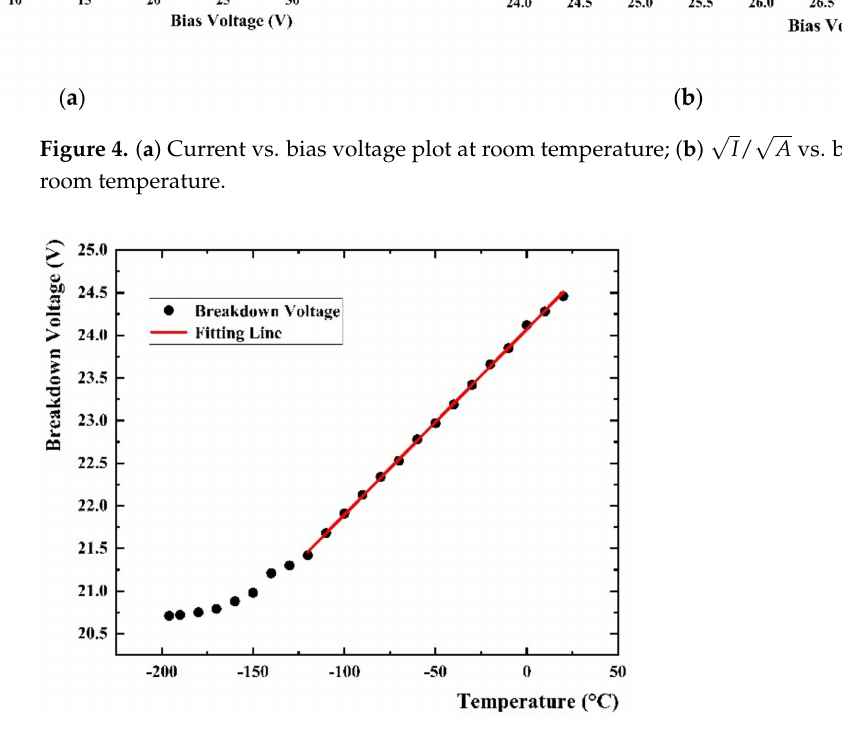
Figure 5. V bd at different temperature, from 20 ◦ C to − 196 ◦